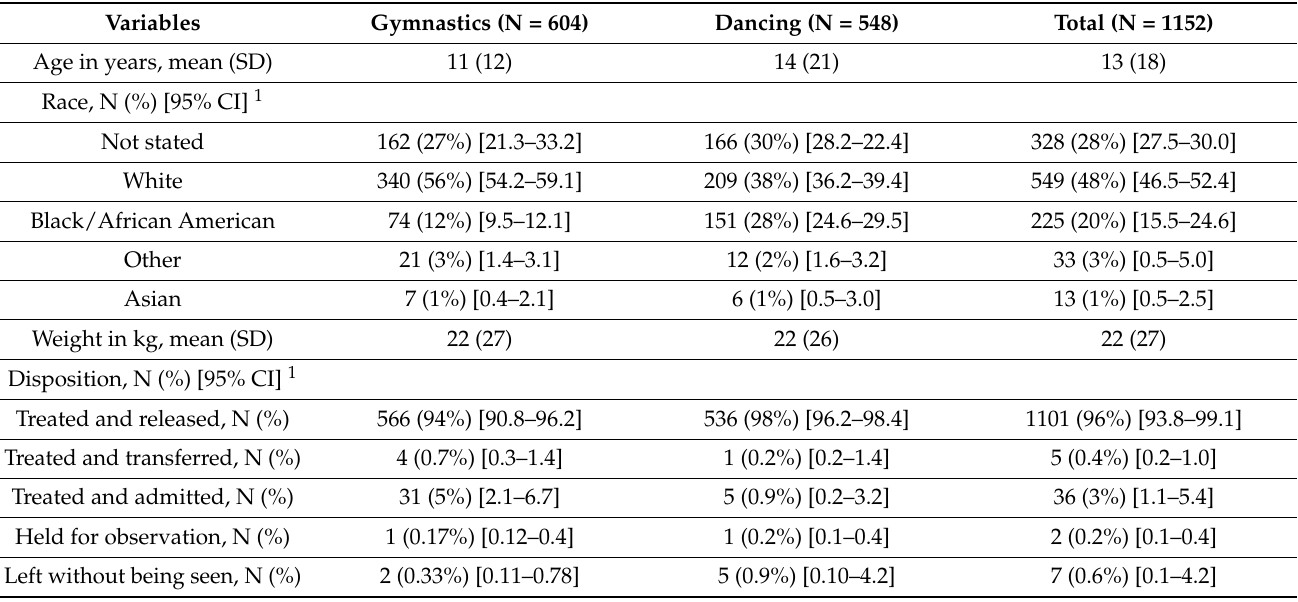
Table 1. Descriptive characteristics of adolescent females with gymnastics and dancing-associated injuries reported to the U. S. NEISS in